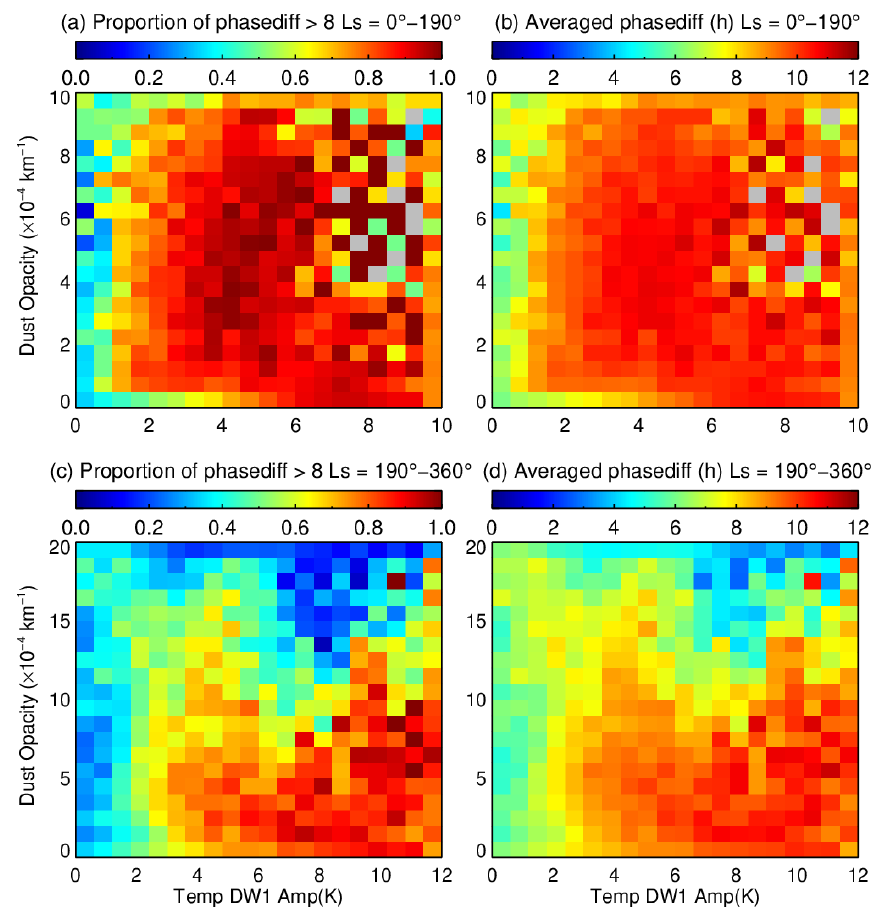
Figure 12. Occurrence frequency of the phase differences larger than 8 h (approximately anticorre- lated) with the temperature DW1 amplitude ( x -axis) and daily mean dust abundance ( y -axis). The statistic includes data of all latitudes from 75°S to 75°N and pressure levels from 200 to 1 Pa during ( a ) Ls = 0°–190° and ( b ) Ls = 190°–360°. ( b , d ) The mean phase difference values corresponding to ( a , c ), respectively. The grey boxes indicate 0 events.